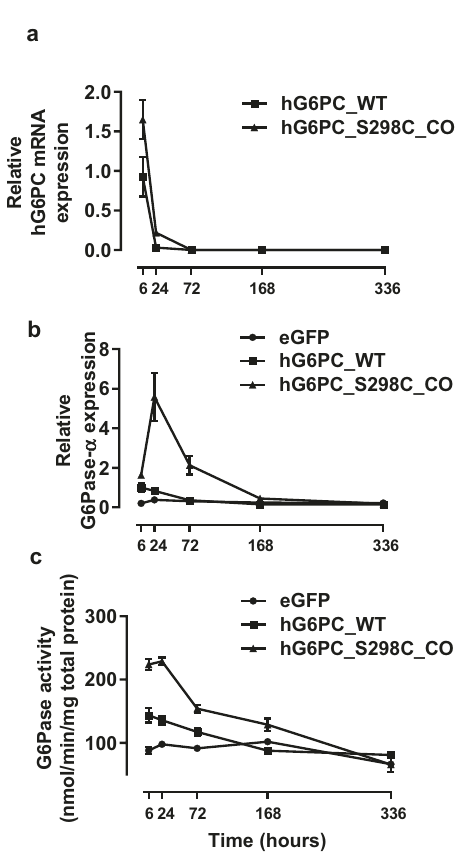
Fig. 3 Hepatic hG6PC mRNA and hG6Pase- α protein and activity half- lives in wild-type mice. Wild-type (CD-1) male mice were i.v. administered with 1.0 mg/kg of eGFP, h G6PC -wild type (WT), or codon-optimized hG6PC -S298C (hG6PC_S298C_CO) mRNA-LNP and sacri fi ced at 6, 24, 72, 168, 336 h ( n = 4/group/sacri fi ce time point). a h G6PC mRNA levels (h G6PC -WT and S298C mRNAs). b Hepatic protein levels in mice treated with eGFP mRNA, mRNA encoding hG6Pase- α WT, or codon-optimized mRNA encoding hG6PC-S298C protein variant. c Hepatic enzymatic activity levels in mice treated with eGFP mRNA, mRNA encoding hG6Pase- α WT, or codon-optimized mRNA encoding hG6PC-S298C protein variant. Data were presented as mean ± SD ( n = 3 – 4). Source data are provided as a Source Data